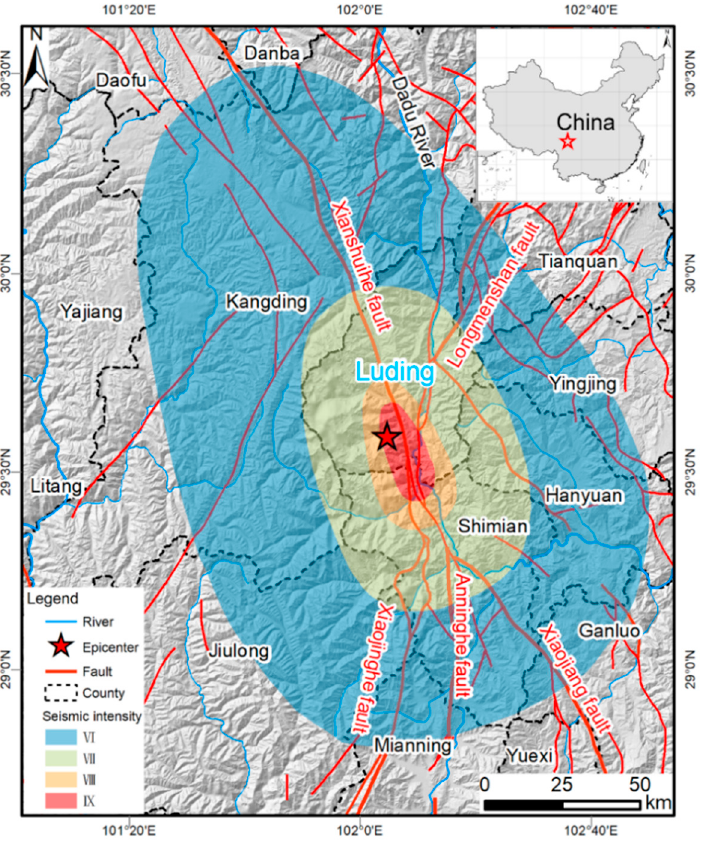
Figure 1. Location of the 2022 Luding earthquake in the southeastern Tibetan Plateau (the seismic intensity is from https://www.mem.gov.cn/xw/yjglbgzdt/202209/t20220911_422190.shtml; accessed on 15 September 2022).